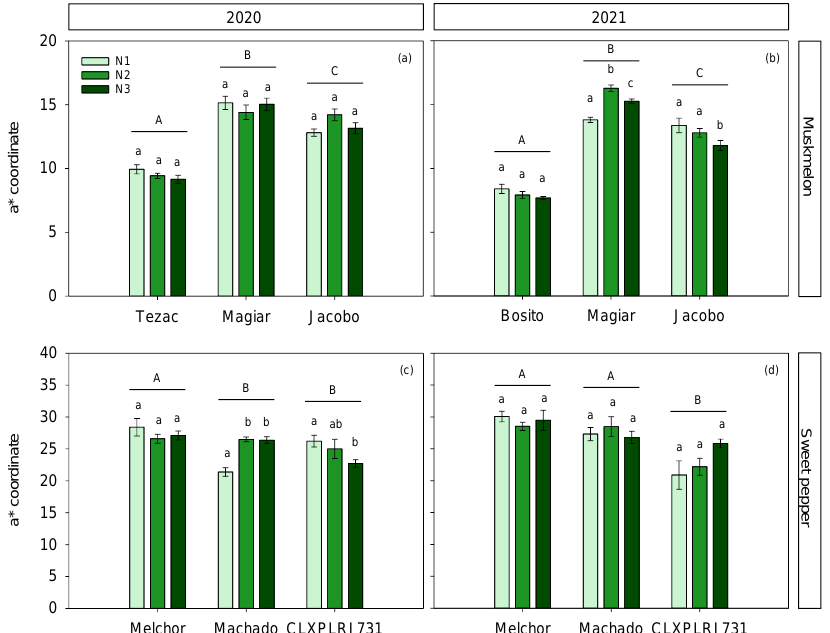
Figure 6. Fruit a* (red–green axis) for three cultivars and three N treatments, for muskmelon ( a , b ) and sweet pepper ( c , d ) crops, conducted in 2020 and 2021 years. Fruit measurements are internal for muskmelon and external for sweet pepper. Different lowercase letters show significant differences between N treatments within each cultivar; different uppercase letters show significant differences between cultivars. Values are means ± SE.